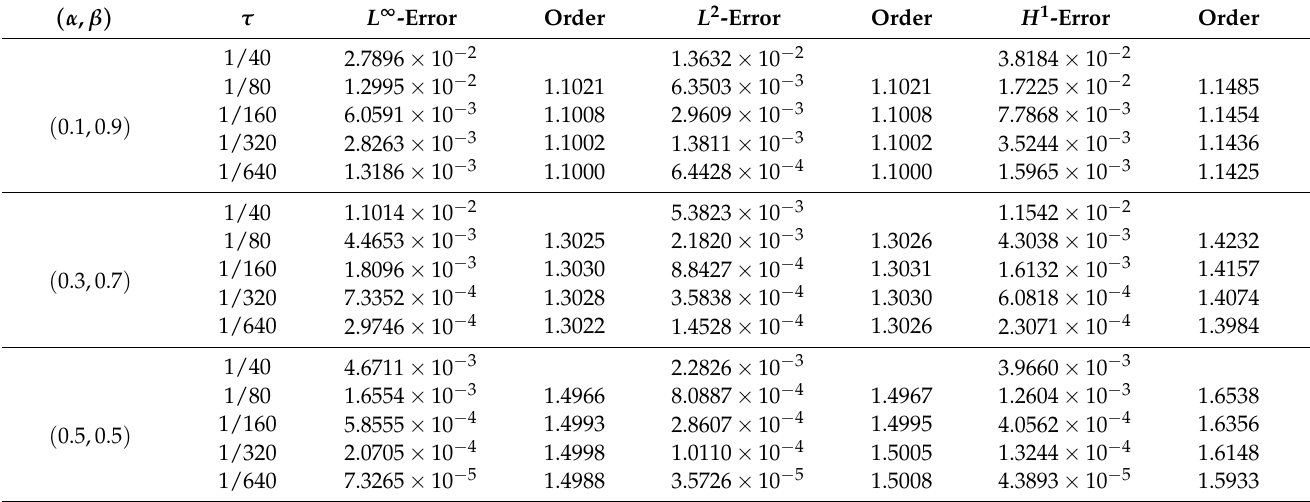
Table 1. The L ∞ , L 2 , H 1 − errors in time for three groups of ( α , β ) at N x = N y =